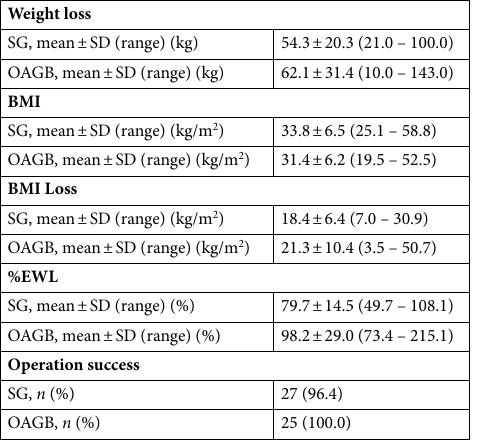
Table 4. Body weight-associated parameters 36 months postoperatively. BMI body mass index, EWL excess weight loss, SG sleeve gastrectomy, OAGB one anastomosis gastric bypass, SD standard deviation.